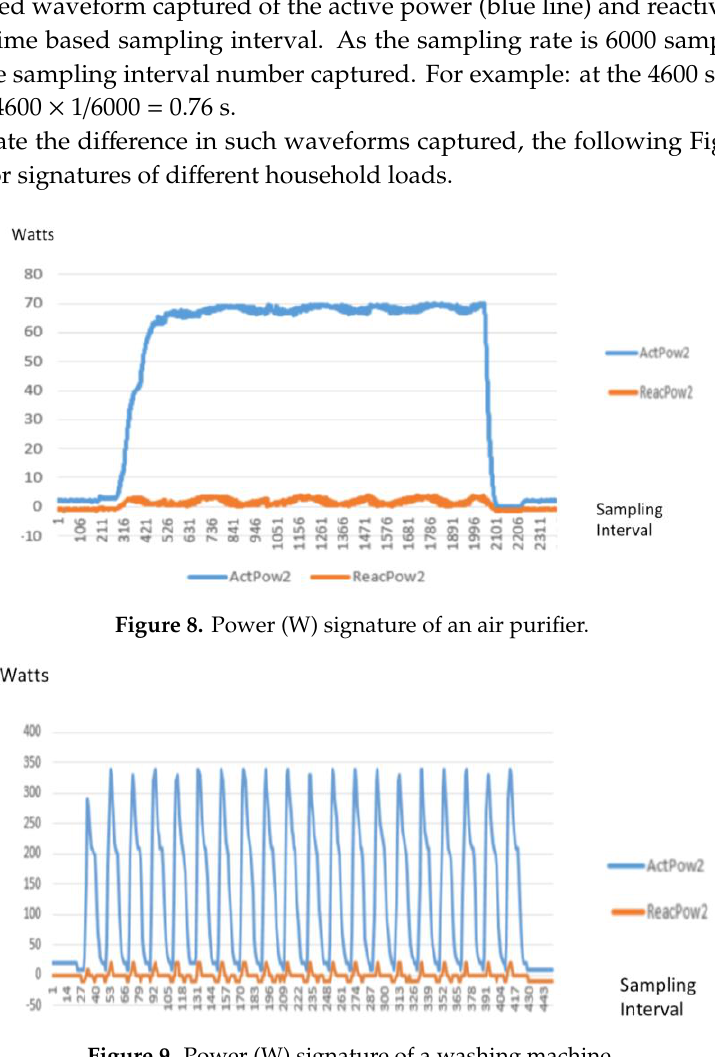
Figure 9. Power (W) signature of a washing machine.